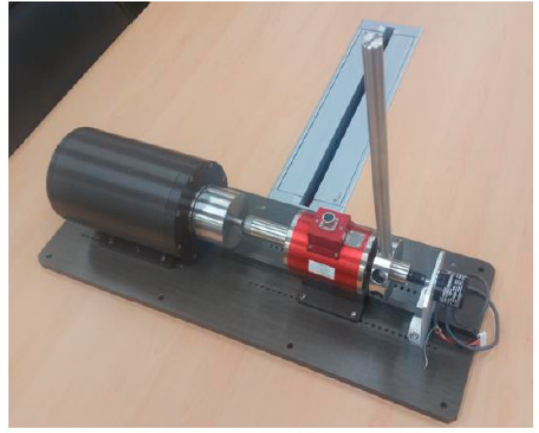
Figure 6. The Type A magnetic coupling configuration is tested for maximum torque.